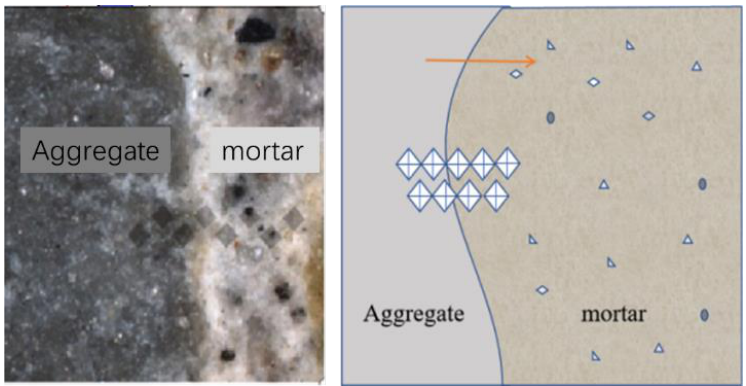
Figure 3. Schematic diagram of microhardness test. (arrow shows the direction of taking diamond shaped points). shaped